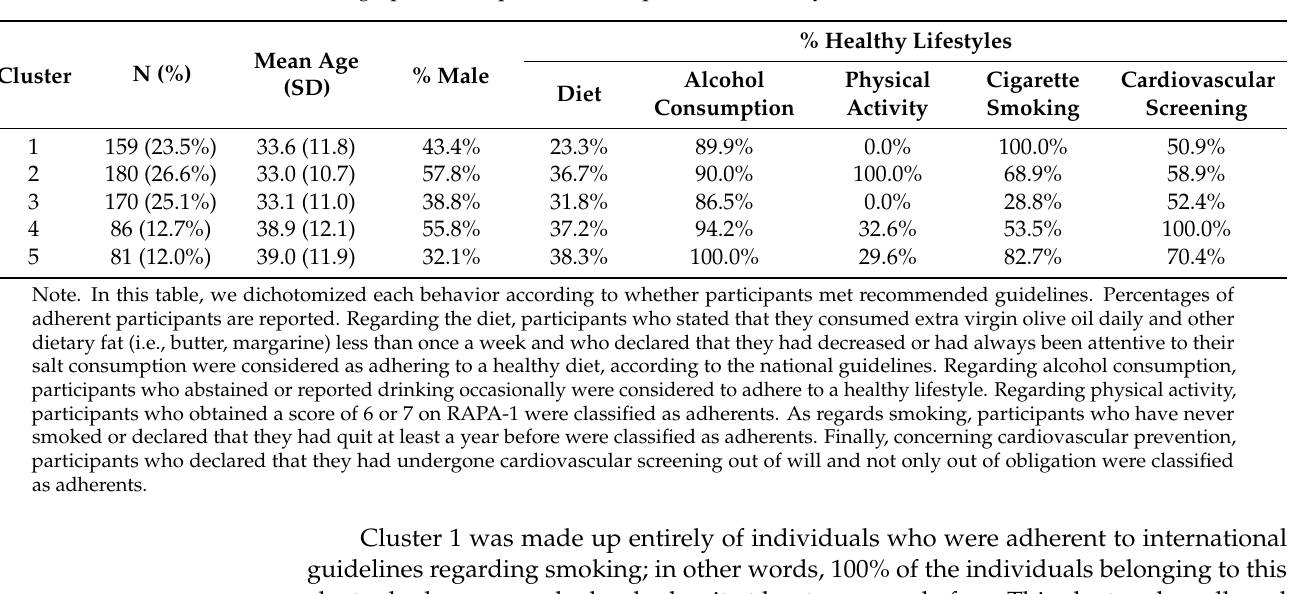
Table 3. Sociodemographic description and adequateness of lifestyle for the clusters